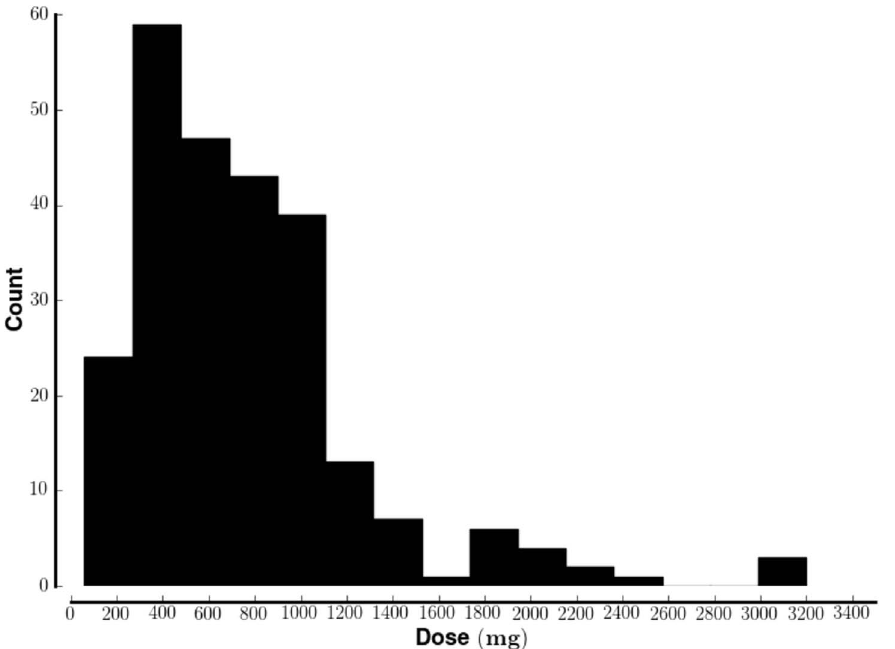
Figure 5. Range of dxm dosages discussed on YouTube. The histogram (bin size ~ 200 mg) shows the distribution of dosages mentioned in the YouTube comments. All doses were converted to milligrams.